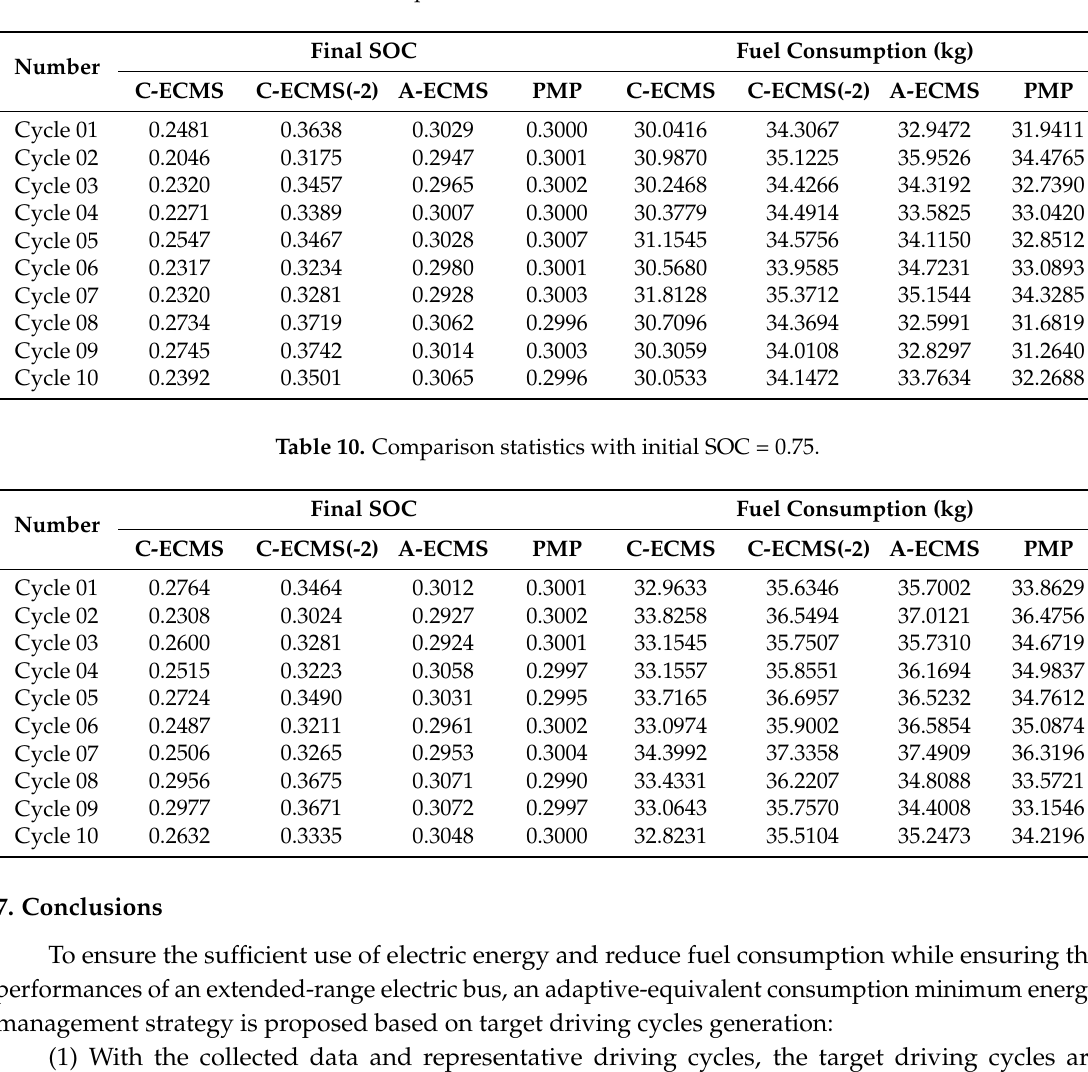
Table 9. Comparison statistics with initial SOC = 0.80.